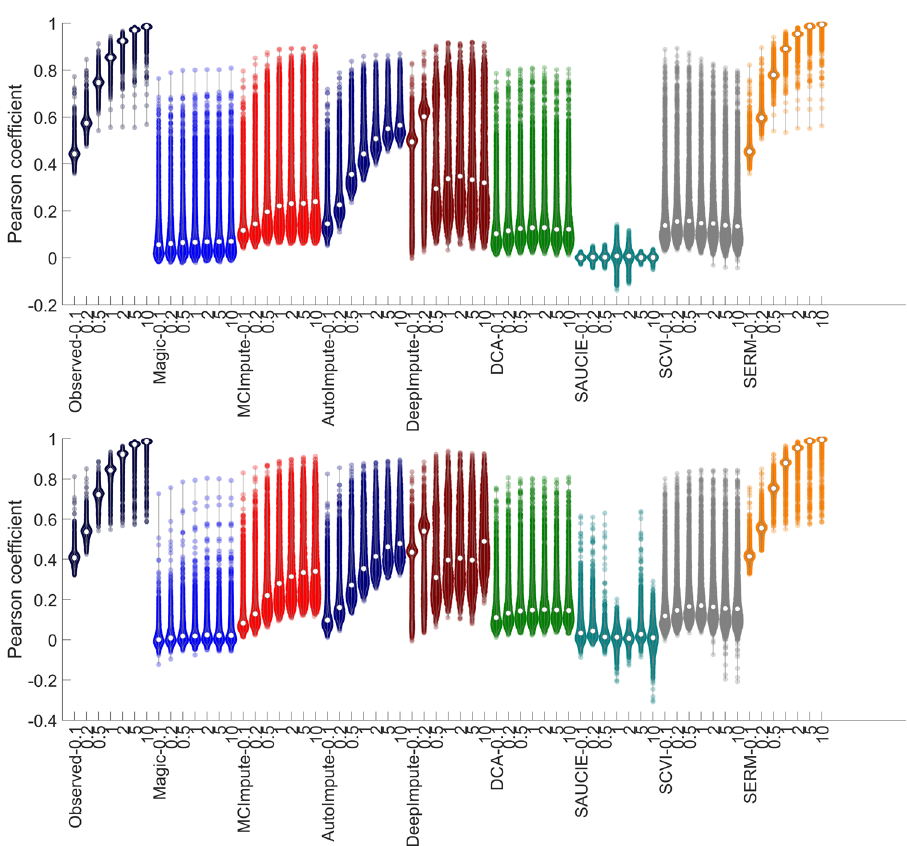
Fig.6|Pearsoncoef fi cientsbetweentheimputedandreferencedataforallthe methods are shown for zebra fi sh development data ( fi rst row), and EB differ- entiation data (second row). The sampling ef fi ciency (0.1 – 10%) to create the observed data are shown in x -axis. The center of the violin (denoted with white